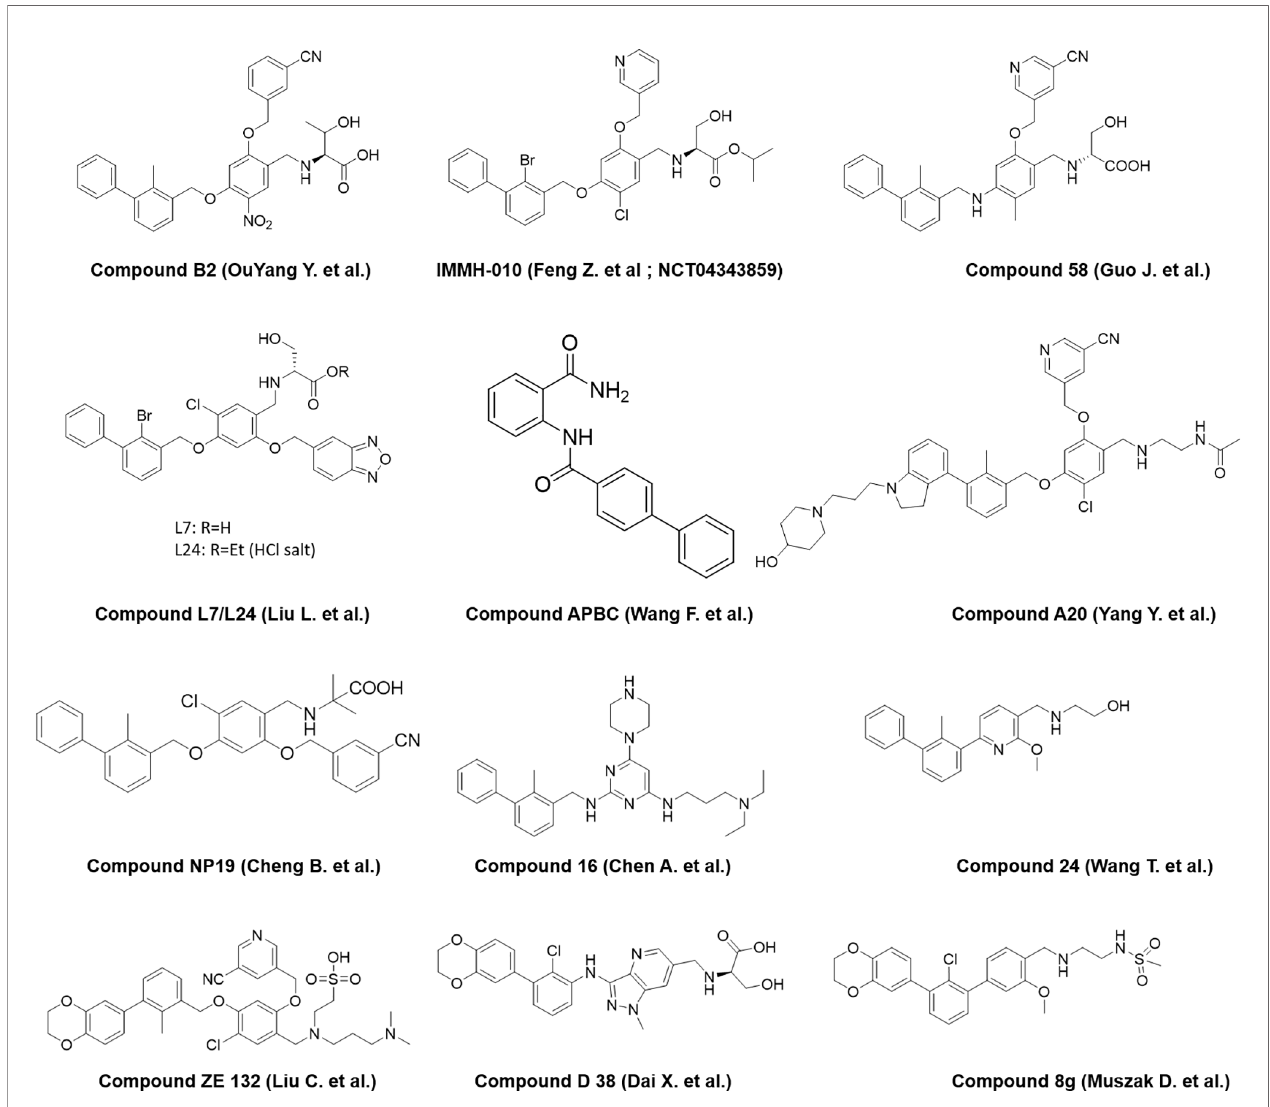
FIGURE 3 | Representative structures of modi fi ed biphenyl analogues without C 2 symmetry but with improved